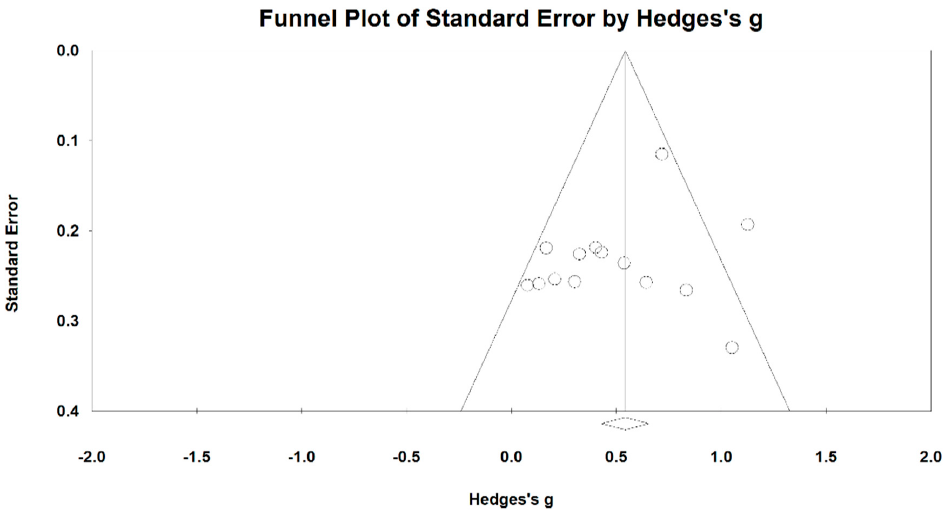
Figure 10. Funnel plot of publication bias for FEV 1